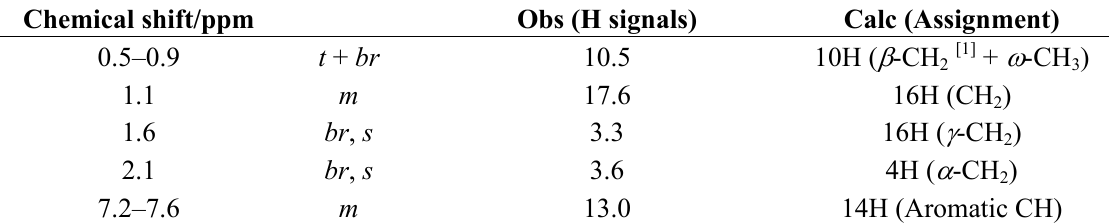
Table 1. Chemical shifts of PF8P2 in CDCl